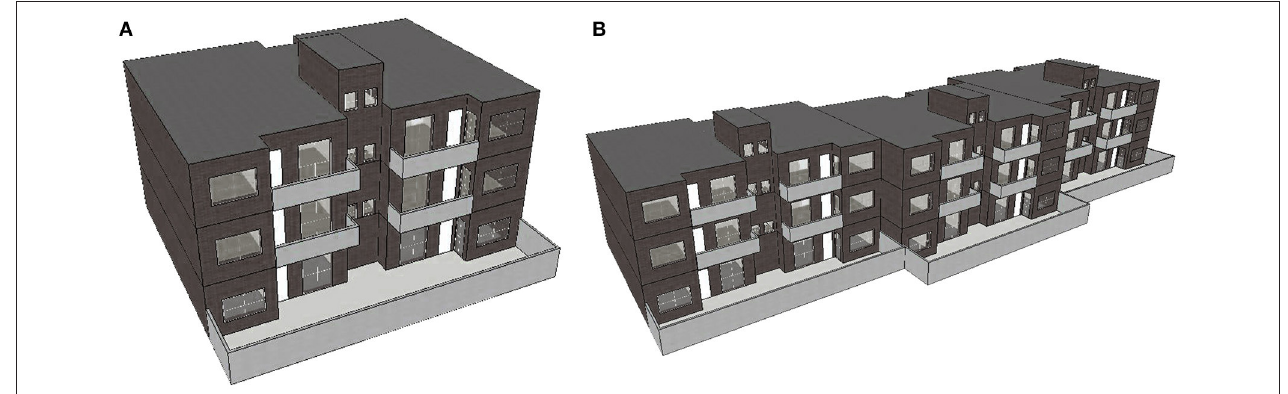
FIGURE 5 | 3D models of the blocks; left to right: (A) Single block. (B) Attached block.